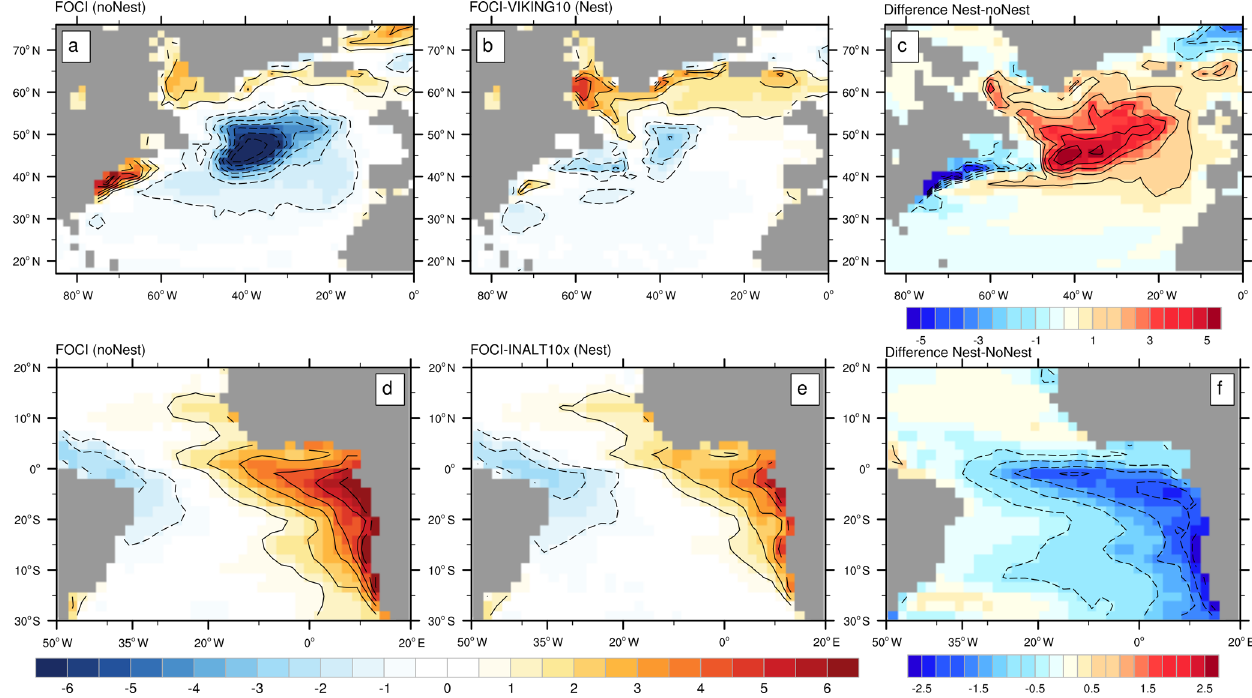
Figure 16. FOCI SST anomalies with respect to observed SSTs (HadISST, 1870–1900) in Kelvin: (a) annual mean FOCI unnested and (b) FOCI_VIKING10-piCtl nested configuration in the North Atlantic; boreal summer (July–September) (d) FOCI-piCtl unnested and (e) FOCI_INALT10X-piCtl nested configuration in the tropical Atlantic. Shared color scale for panels (a) , (b) , (d) and (e) ; contour in- terval of 1K for (a) – (e) and 0.5K for (f) . The global mean SST has been removed from FOCI as well as HadISST data prior to anomaly calculations to eliminate the influence of different mean